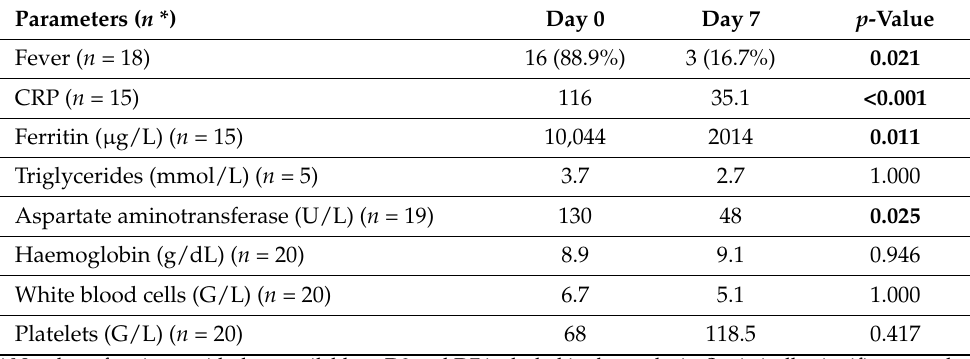
Table 3. Evolution of clinical and biological features under